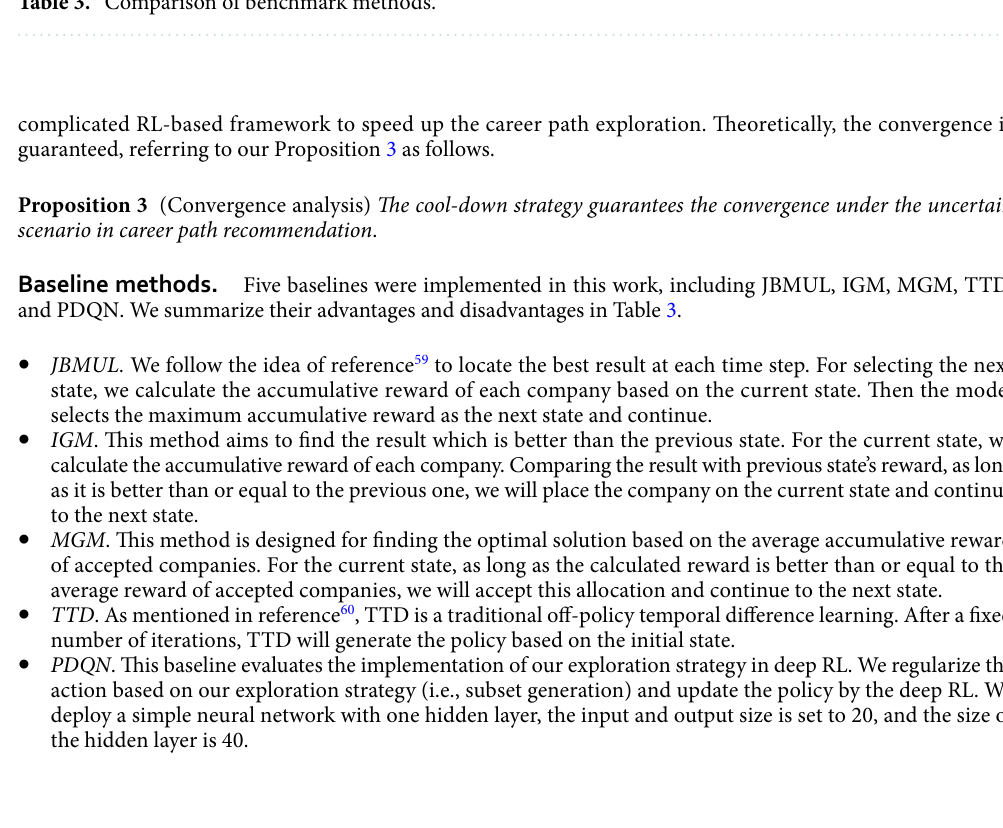
Table 3. Comparison of benchmark